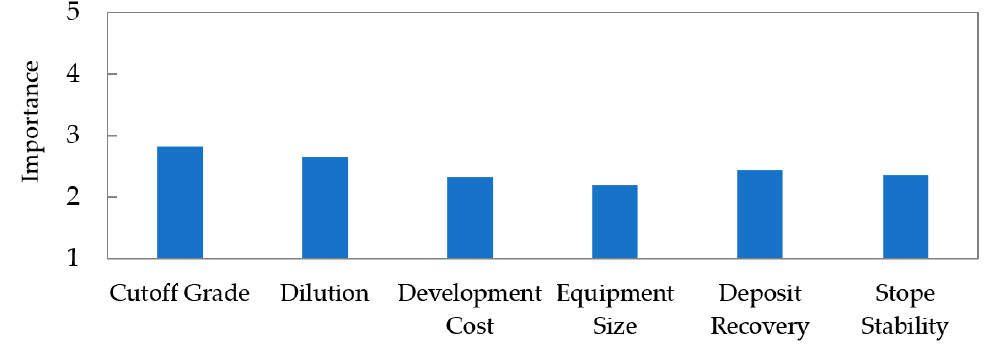
Figure 9. Impact of factors on stope design (1 = very unimportant to 5 = very important).